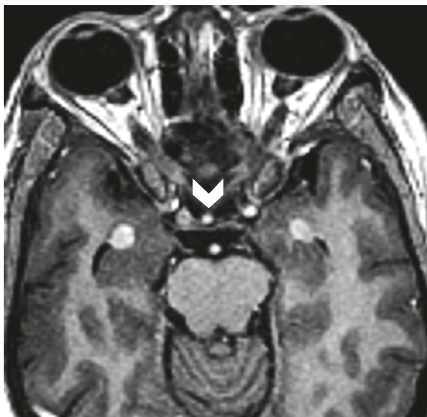
Figure 4: Postcontrast axial T1 weighted images of the brain at the level of the orbits showing the thickened enhanced pituitary stalk (arrow head) almost reaching the same size of the enhanced basilar artery. Note also the enhancing bilateral lesions anterior to the amygdala.